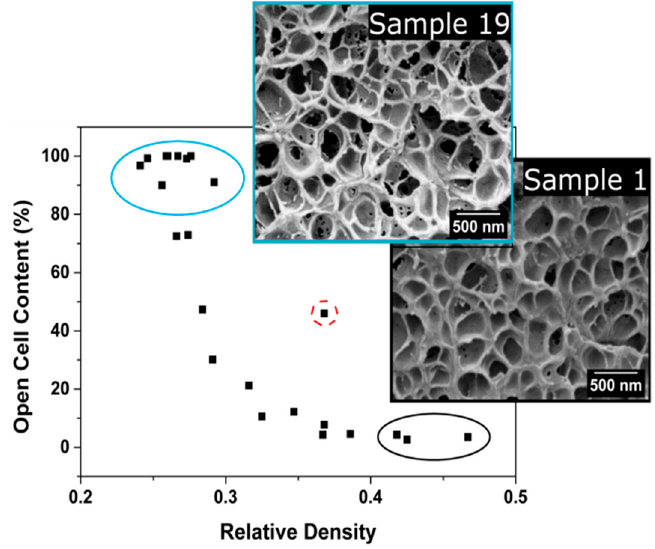
Figure 8. Open cell content as a function of relative density.